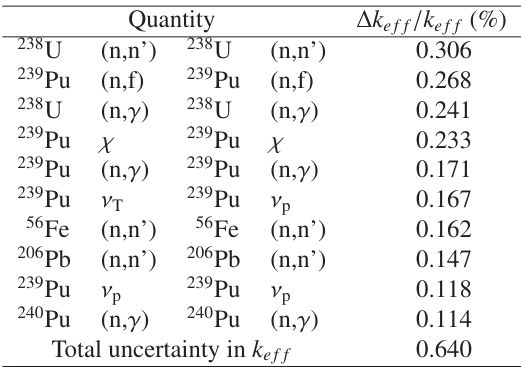
Table 3. k ef f uncertainty quantification for ALFRED with